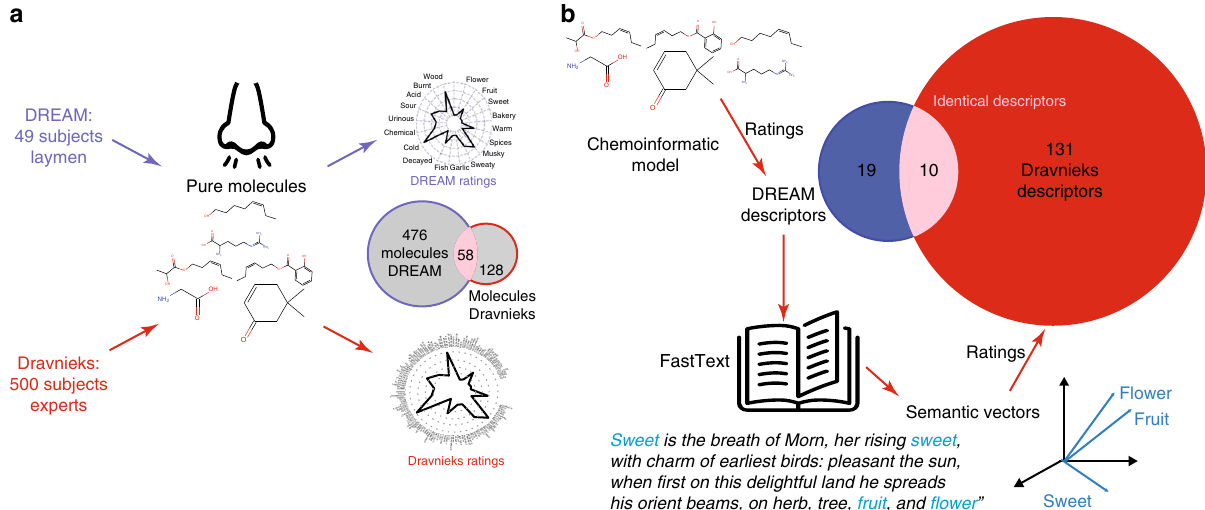
Fig. 1 Construction of a universal perceptual map. a Diagram describing similitudes and differences between the DREAM and Dravnieks psychophysical olfactory datasets. Dravnieks dataset used olfaction experts, a smaller set of 128 molecules, 58 overlapping with DREAM, and a large set of 146 descriptors, 10 descriptors overlapping with DREAM. b Diagram showing the approach to predict ratings for the Dravnieks descriptor sets. For non-overlap molecules between the datasets, a chemoinformatic model helps predicting ratings for values of the DREAM set of 19 perceptual descriptors. We then use fastText to generate semantic vectors for the DREAM and Dravnieks descriptors by searching for co-occurrence of words in sentences as shown in the example (a fragment of Milton ’ s Paradise Lost ). A model using these vectors is then applied to DREAM ratings/predictions to generate Dravnieks rating values for